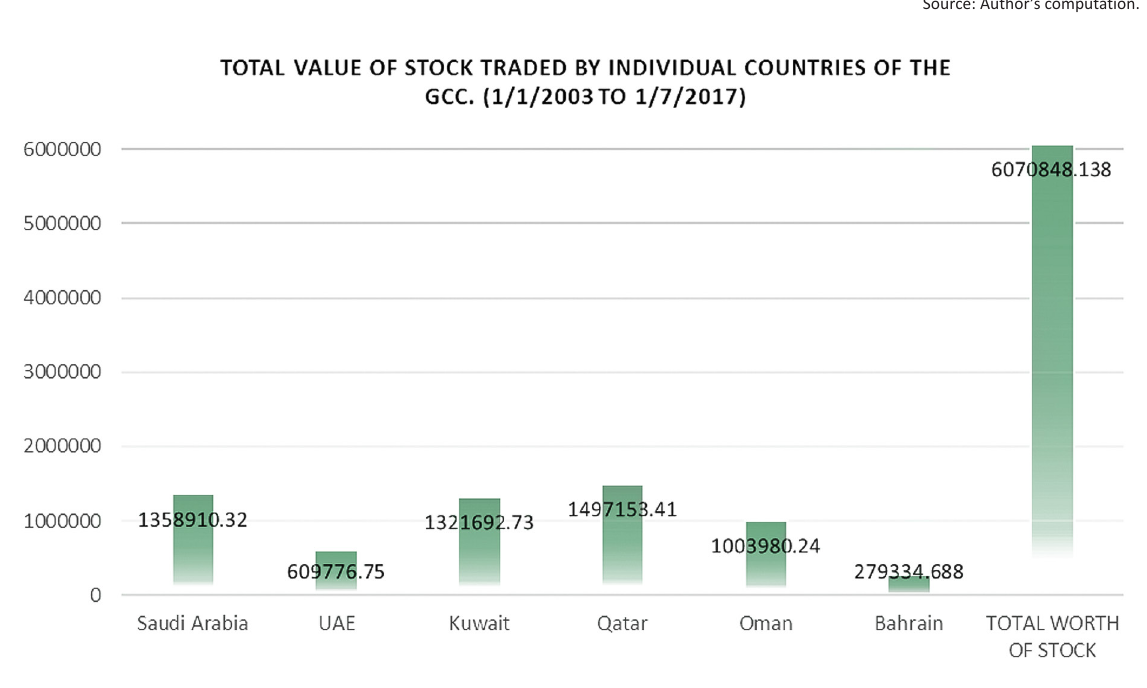
Figure 1. Individual stock traded from 1/1/2003 to